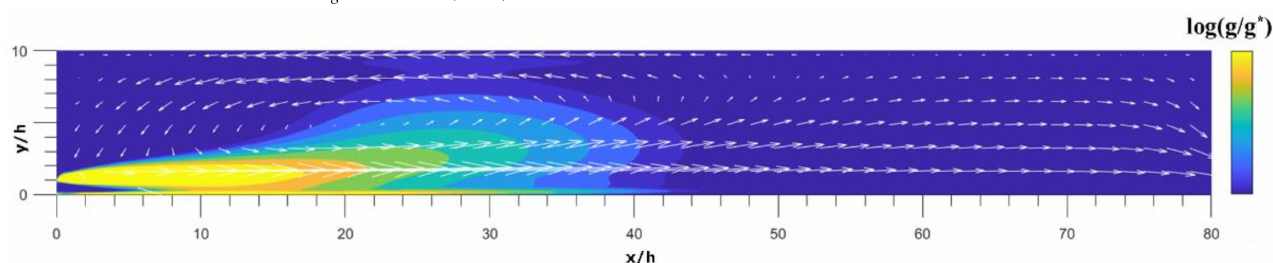
Figure 11. Case C: Inhomogeneous flow and breakup frequency ( p = 1). Set breakup frequency (line) compared to global estimate (circles: uncorrected, squares: RTD-corrected)) at different drop diameters, D. Results from three flow conditions: U g = 1.5 m/s ( black ), U g = 3.0 m/s ( red ) and U g = 6.0 m/s ( blue ).